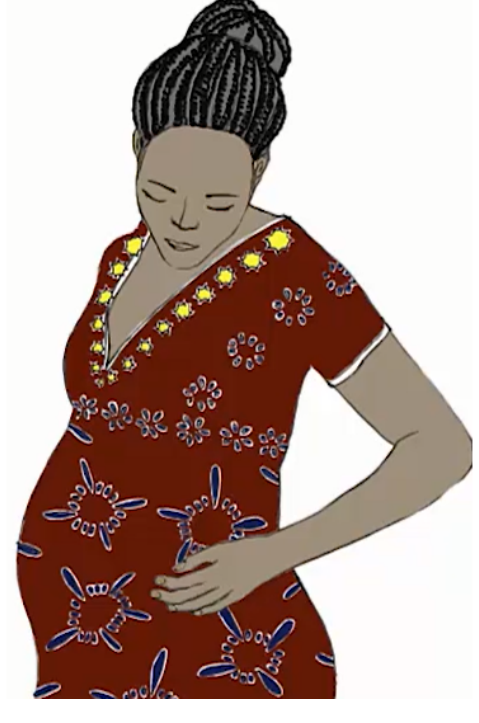
Figure 2. Farida before